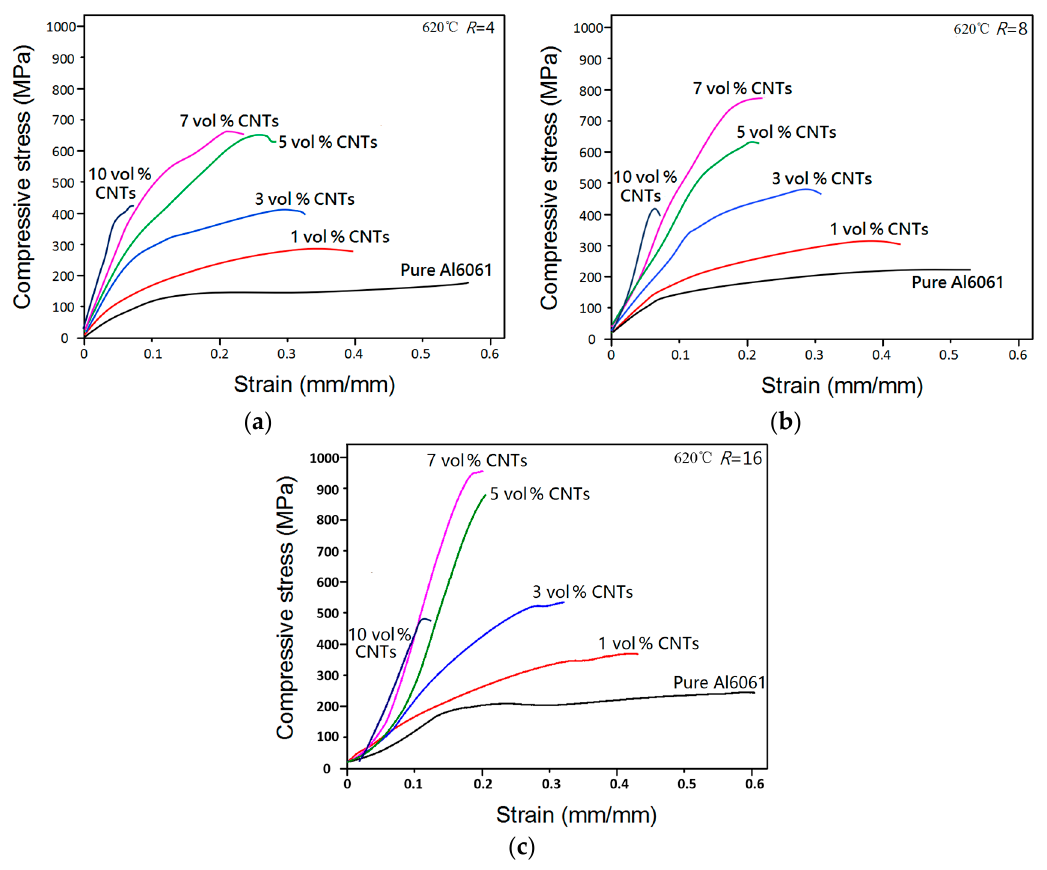
Figure 14. Compressive stress depending on extrusion ratio: ( a ) R = 4; ( b ) R = 8 and ( c ) R = 16.